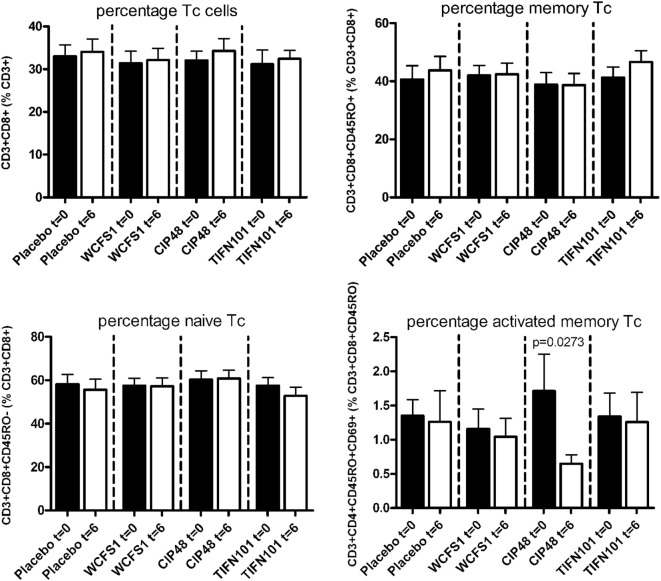
Effects of three Lactobacillus plantarum strains on the frequency of CD8+ T-cell populations in systemic circulation. Data are expressed as mean ± SEM. Statistical significant differences were determined by using two-sided Student’s t-tests. A p-value <0.05 was considered statistically significant. A p-value <0.1 was considered a statistical trend.